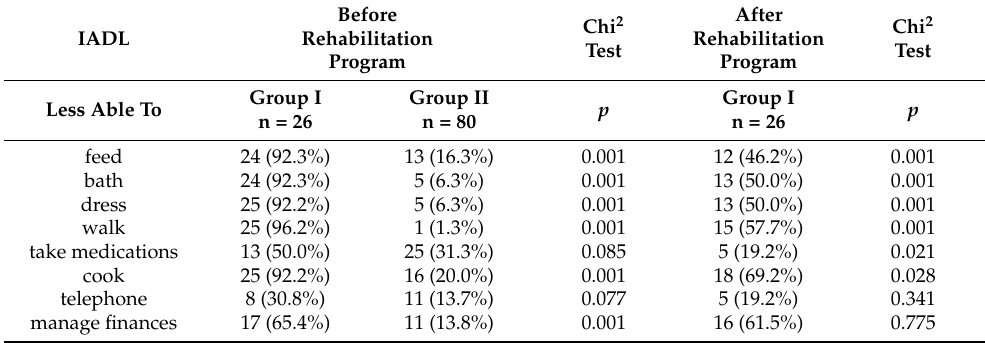
Table 10. IADL evaluation in SARS CoV-2 patients with pneumonia before and after the rehabilitation